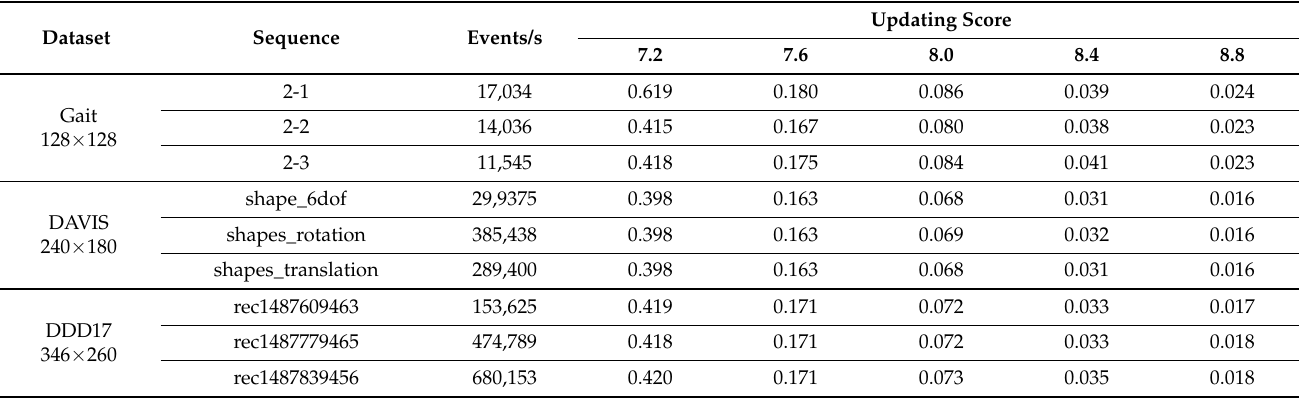
Table 4. Time ( µ s) spent on encrypting one event on desktop server ( K = 253,725,220) using different updating scores and NVSs with different resolutions.